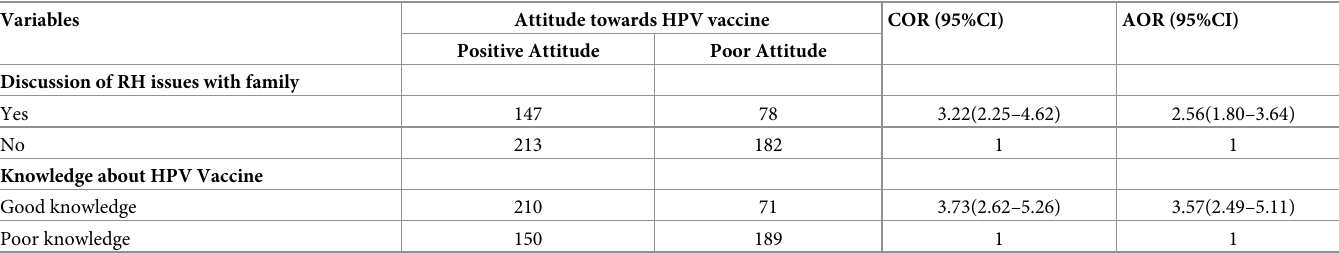
Table 5. Factors associated with attitude about HPV vaccination among female preparatory school students, Bahir Dar, Ethiopia, 2021. Variables